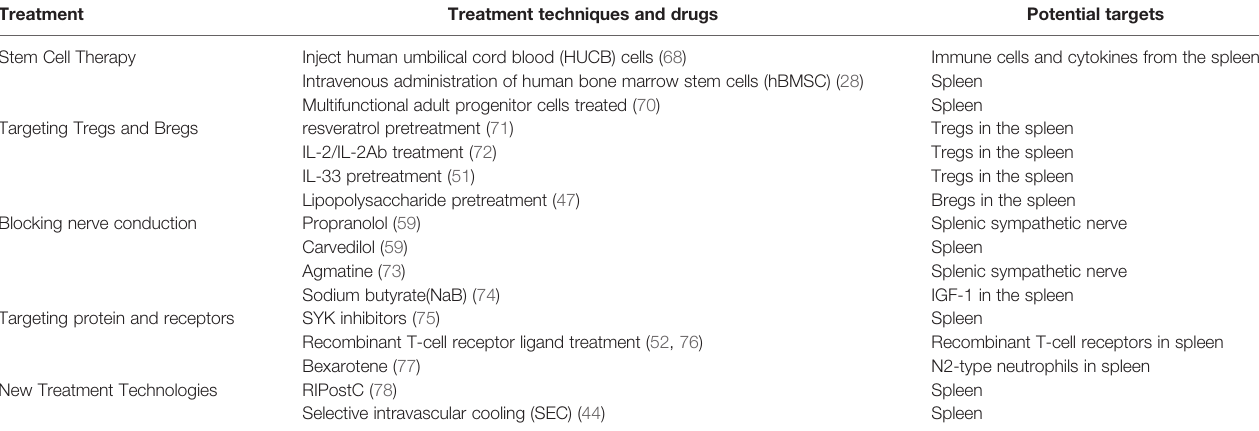
TABLE 2 | Spleen as a potential therapeutic target. Treatment Treatment techniques and